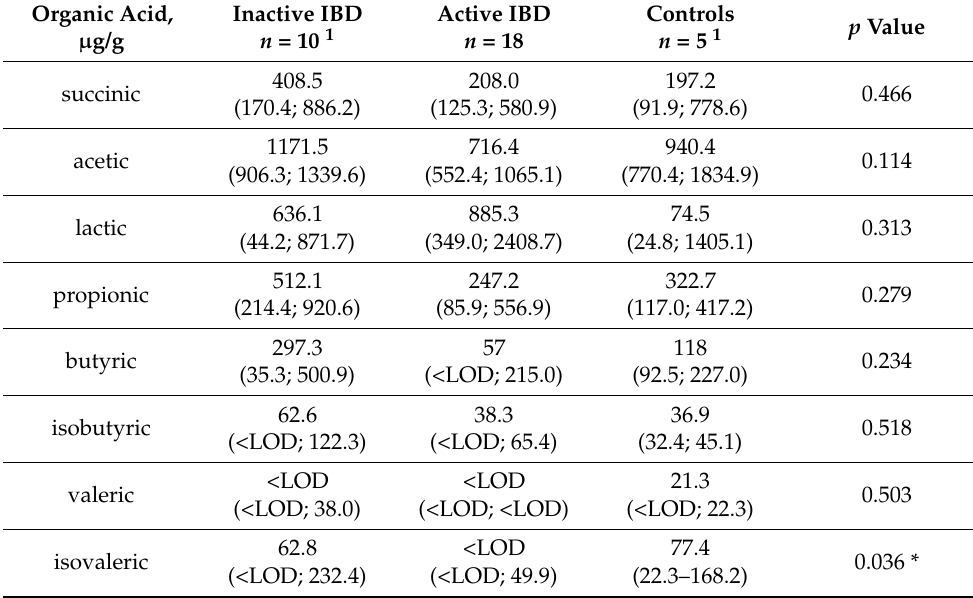
Table 6. Organic acid levels in patients with inactive IBD, active IBD, and controls.